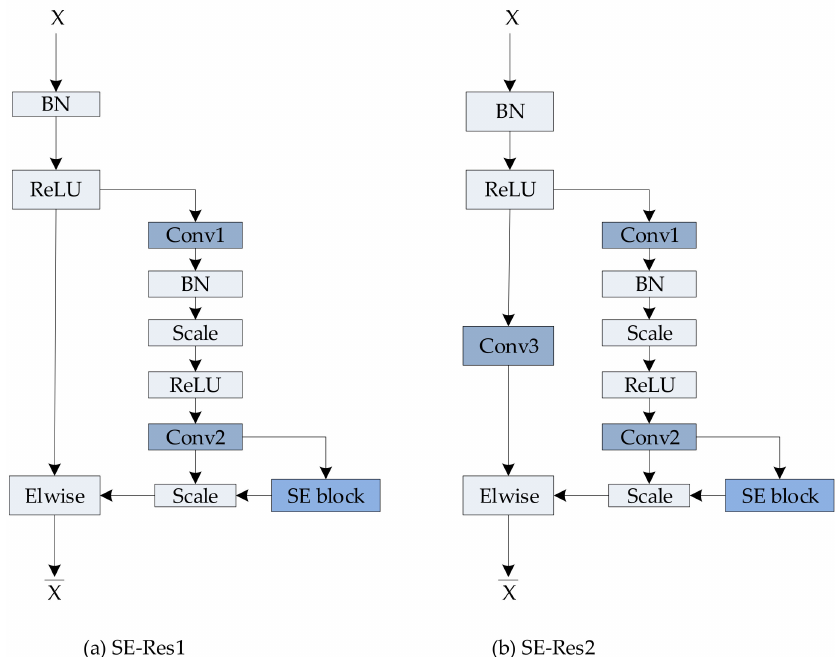
Figure 8. Two connected schemas of the SE-Res module. ( a ) Represents that the output of two branches have the same channels contrary to ( b ). Here Conv1, Conv2, and Conv3 all represent the